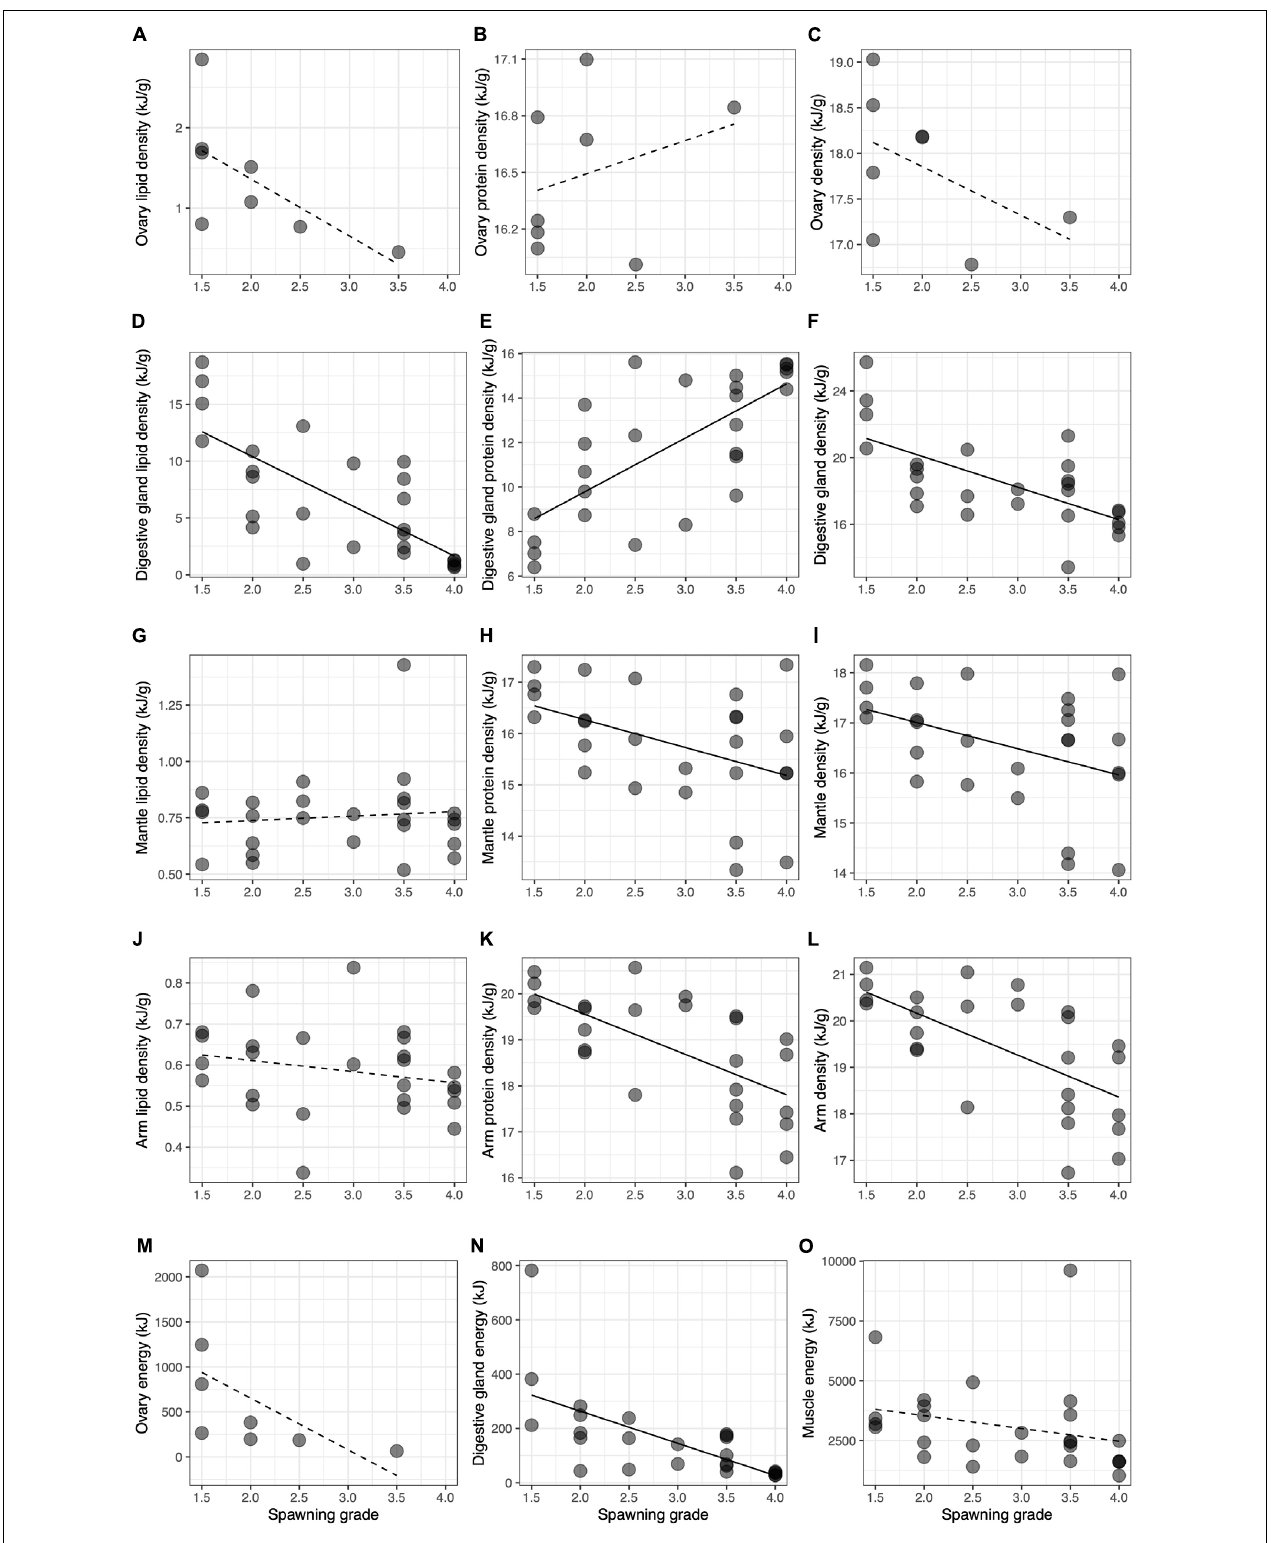
FIGURE 11 | Bivariate relationships between energy density and spawning grade for lipids (A,D,G,J) and proteins (B,E,H,K) for each tissue in macrostage V females. Shown are also the relationships between energy density (C,F,I,L) and total energy (M,N,O) for each tissue. Solid lines indicate that the slope is statistically significant ( p <